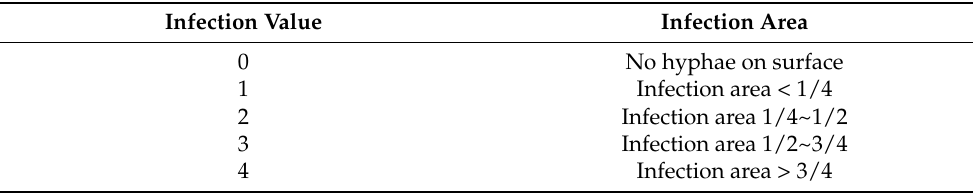
Table 1. Classification of the infection